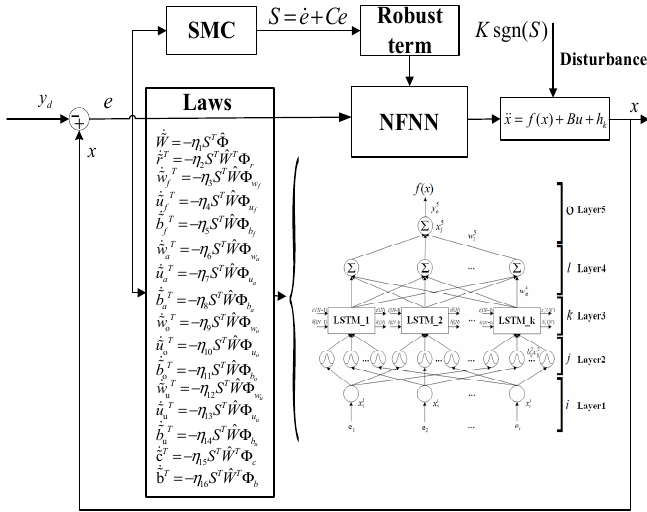
Figure 3. Block diagram of the proposed control system. According to the universal approximation rule, there are optimal weights to use the output of the NFNN to estimate any smooth nonlinear function. Consequently, a NN is designed to identify the unknown terms of the